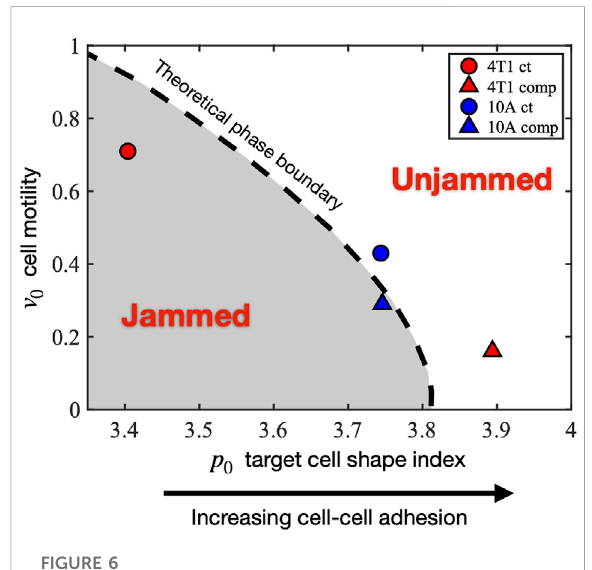
FIGURE 6 Mapping the experimentally observed tissue states to the theoretical jamming – unjamming phase diagram. The jamming – unjamming phase diagram is shown in terms of the two pertinent parameters of the SPV model: the single-cell motility v 0 and the target cell shape index p 0 . By mapping the experimentally observed cell traction forces and cell shapes to theoreticalsimulationresults,thepositionsof4T1and10Acellsare placed on the phase diagram (see